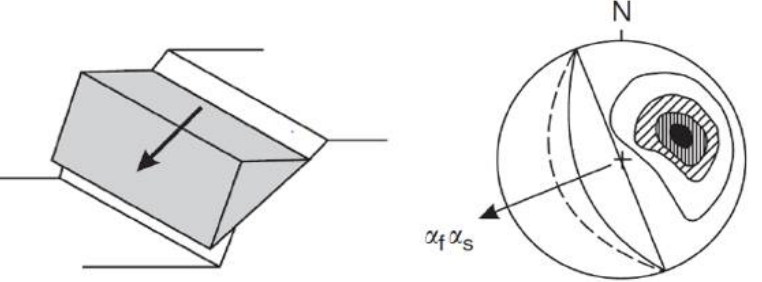
Figure 5. Pre-existing joints dipping out of slope face and striking parallel to the face (Adapted from [44]).